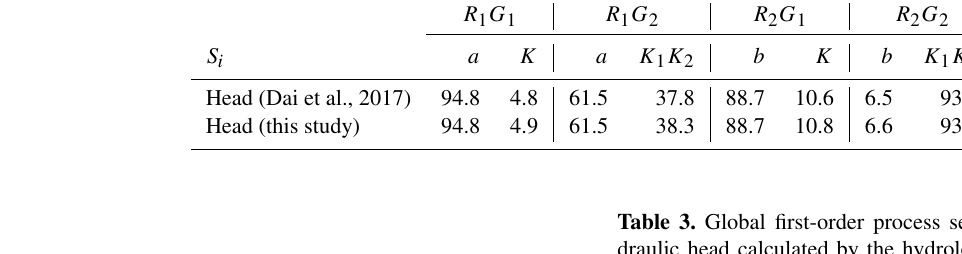
Table 2. Global first-order parameter sensitivity index ( S i ) for hydraulic head calculated by the hydrology model described in Dai et al. (2017); calculated using Saltelli’s algorithm. Results are presented from Dai and using MAAT in this study, demonstrating the correct implementation of Saltelli’s algorithm in MAAT. The slight differences are caused by random sampling. R 1 G 1